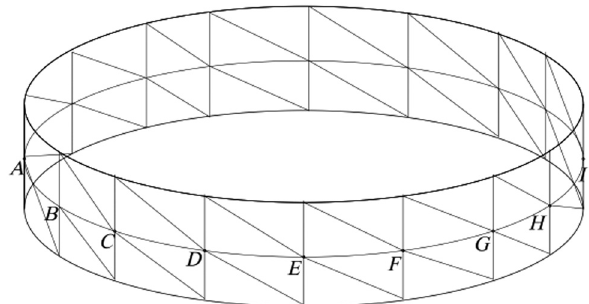
Figure 7: Mesh of the